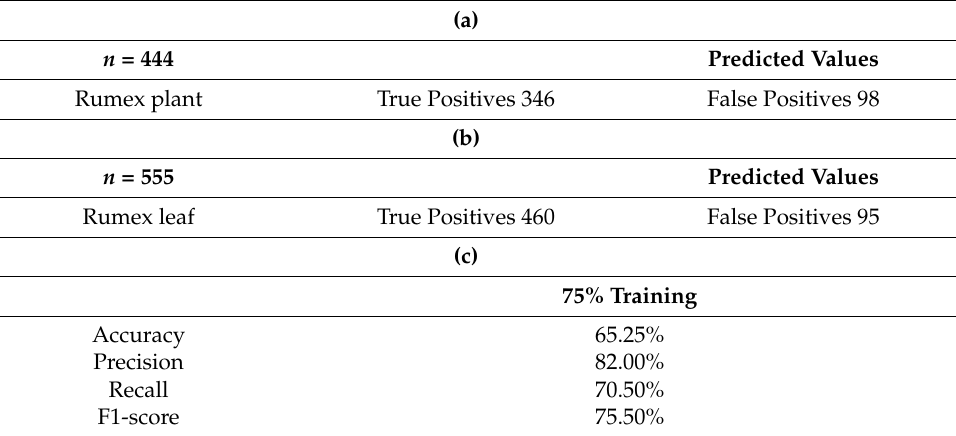
Table 2. ( a ) Shows a confusion matrix about the Rumex plant; ( b ) shows a confusion matrix about the Rumex leaf; ( c ) displays a validation measures table after 75